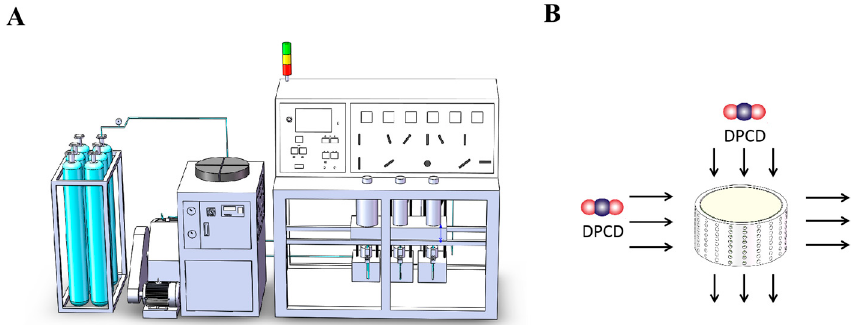
Figure 1. DPCD processing unit diagram ( A ) and mold drawing ( B ): colorful balls is dense phase carbon dioxide .